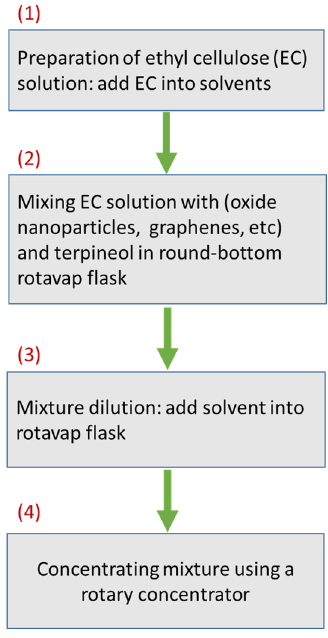
Figure 2. Preparation of pastes used for